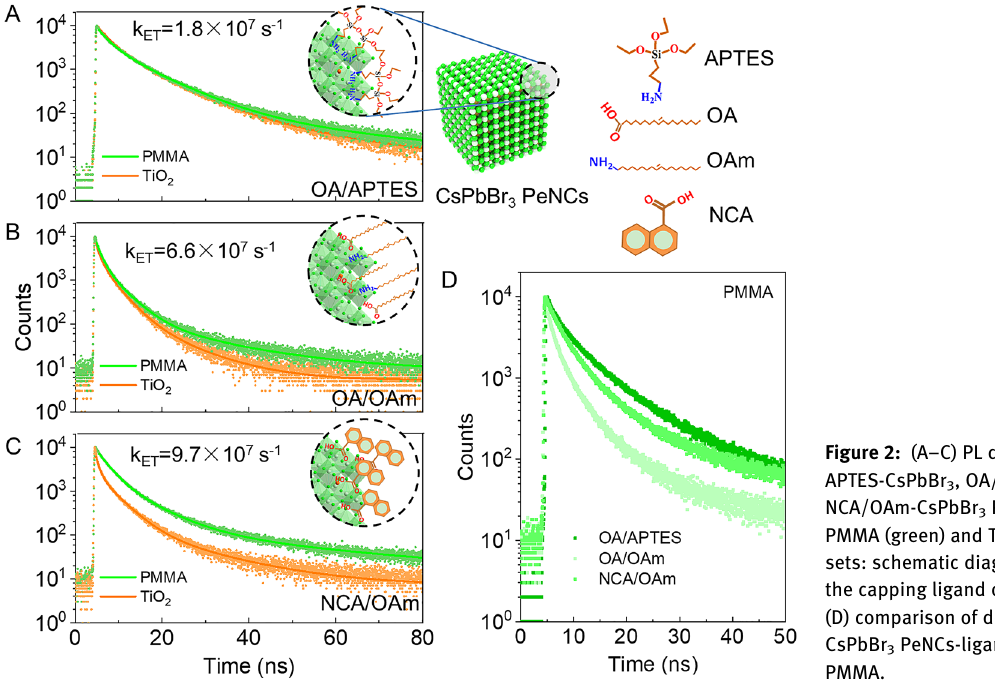
Table  : Multiexponential fi tting parameters for PL decays of CsPbBr  PeNCs on TiO  and